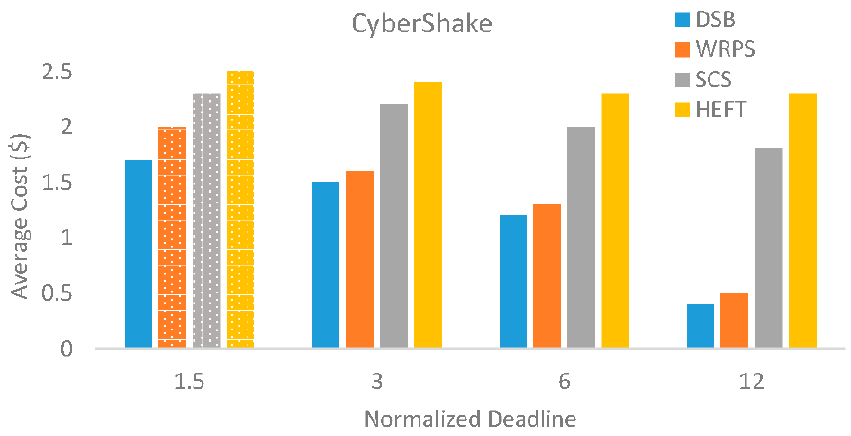
Figure 4. Average cost of CyberShake under varied normalized deadline.